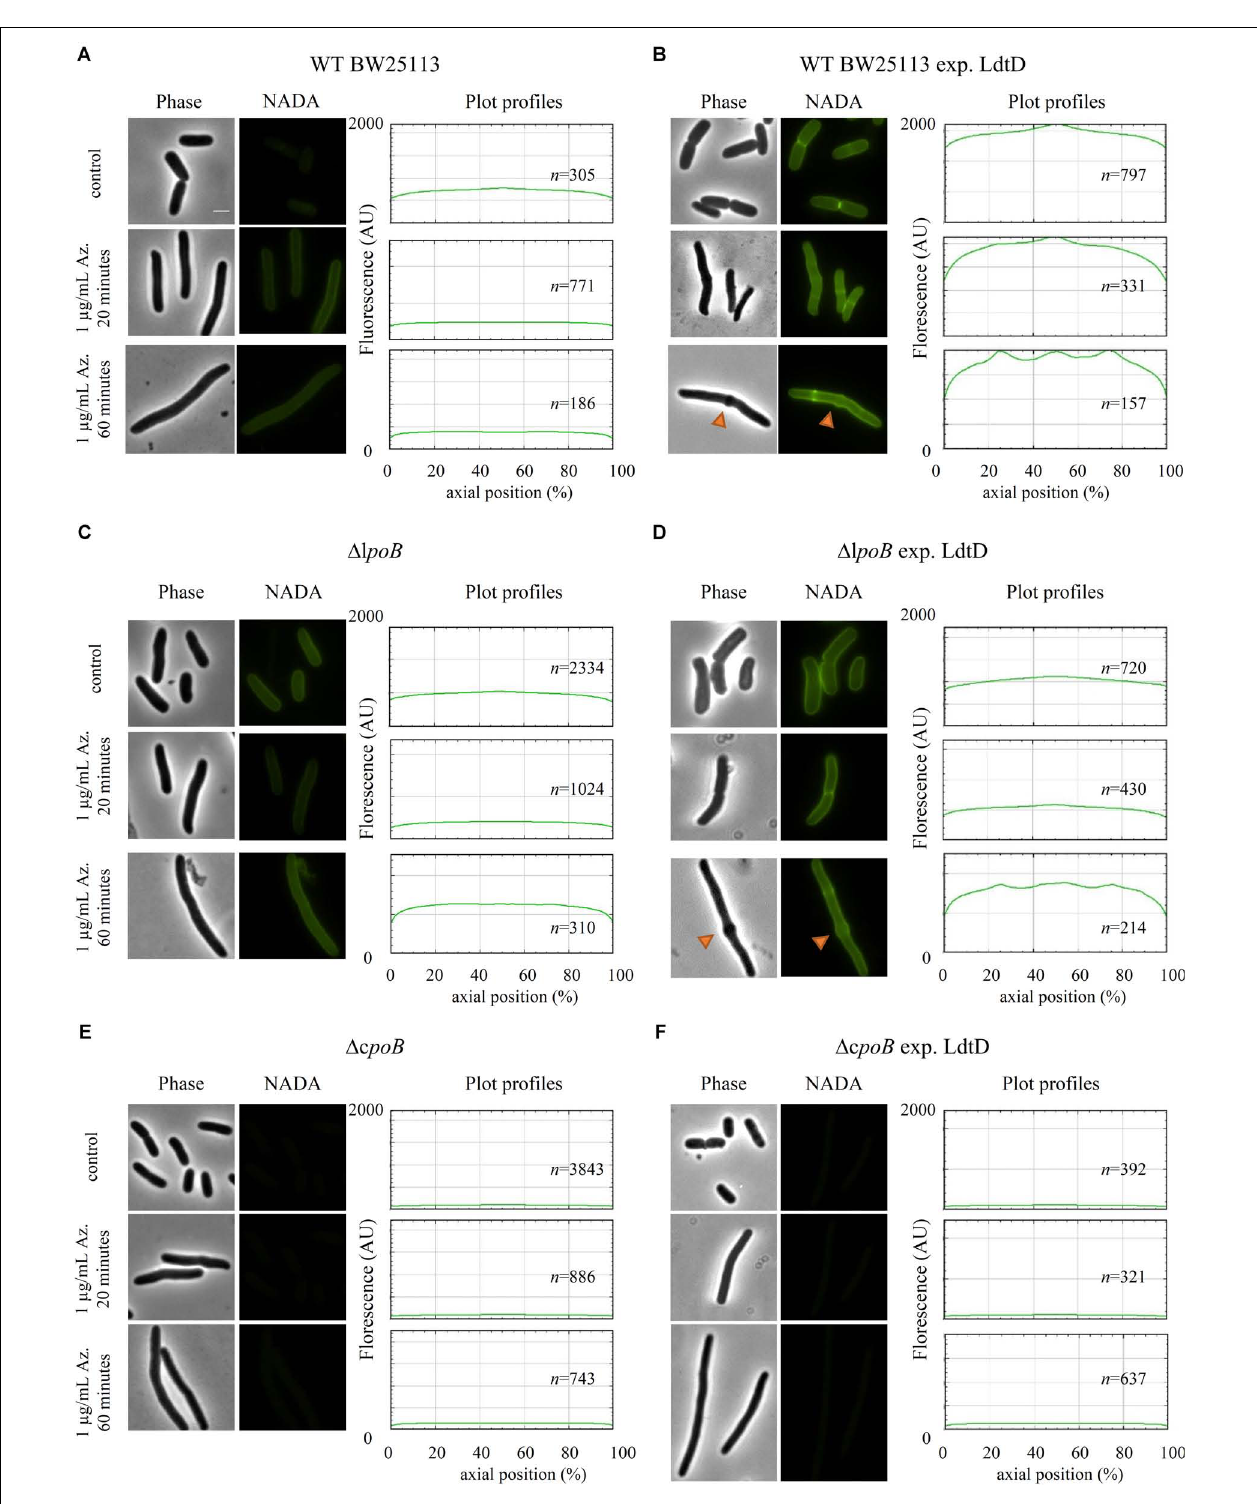
FIGURE 7 | ldtD expression in aztreonam-treated cells creates bulges at mid-cell. Phase contrast images, corresponding fluorescent images, and fluorescence profiles per average cell (from 0 to 2000 AU) plotted against normalized cell length (from 0 to 100%). (A) BW25113, (B) BW25113 expressing ldtD , (C) BW25113 (cid:49) lpoB , (D) BW25113 (cid:49) lpoB expressing ldtD , (E) BW25113 (cid:49) cpoB , and (F) BW25113 (cid:49) cpoB expressing ldtD . Upper panel, no antibiotic; middle panel, 20 min incubation with 1 µ g/mL aztreonam; lower panel, 60 min of incubation with 1 µ g/mL aztreonam. PG was labeled with 0.5 mM NADA with a 2 min labeling pulse after the 20 or 60 min incubation with aztreonam. Scale bar, 2 µ m. Red triangles point to mid-cell bulges. n represents the number of cells analyzed.